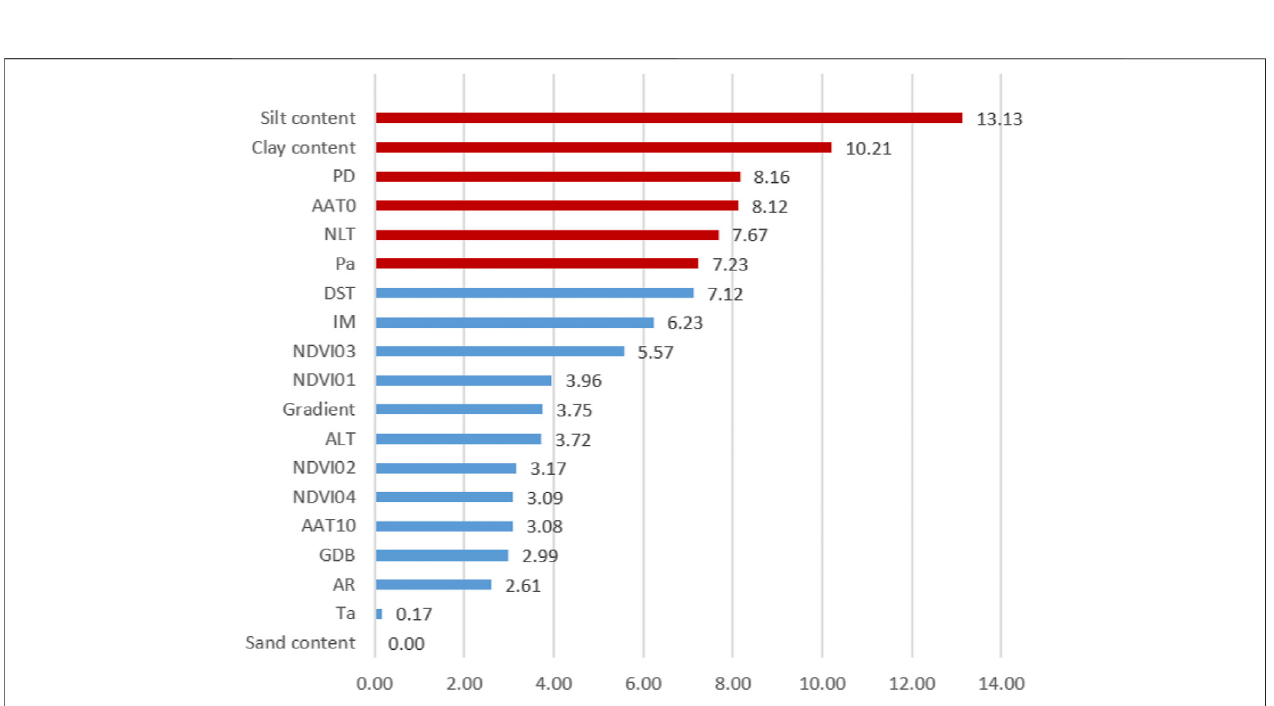
FIGURE 3 | Area under the receiver operating characteristic curve (ROC) of fi ve ecological niche models. C5.0, C5.0 algorithm; GBM, generalized boosted model algorithm; RF, random forest algorithm; SVM, support vector machine algorithm; XGB, eXtreme gradient boosting algorithm.